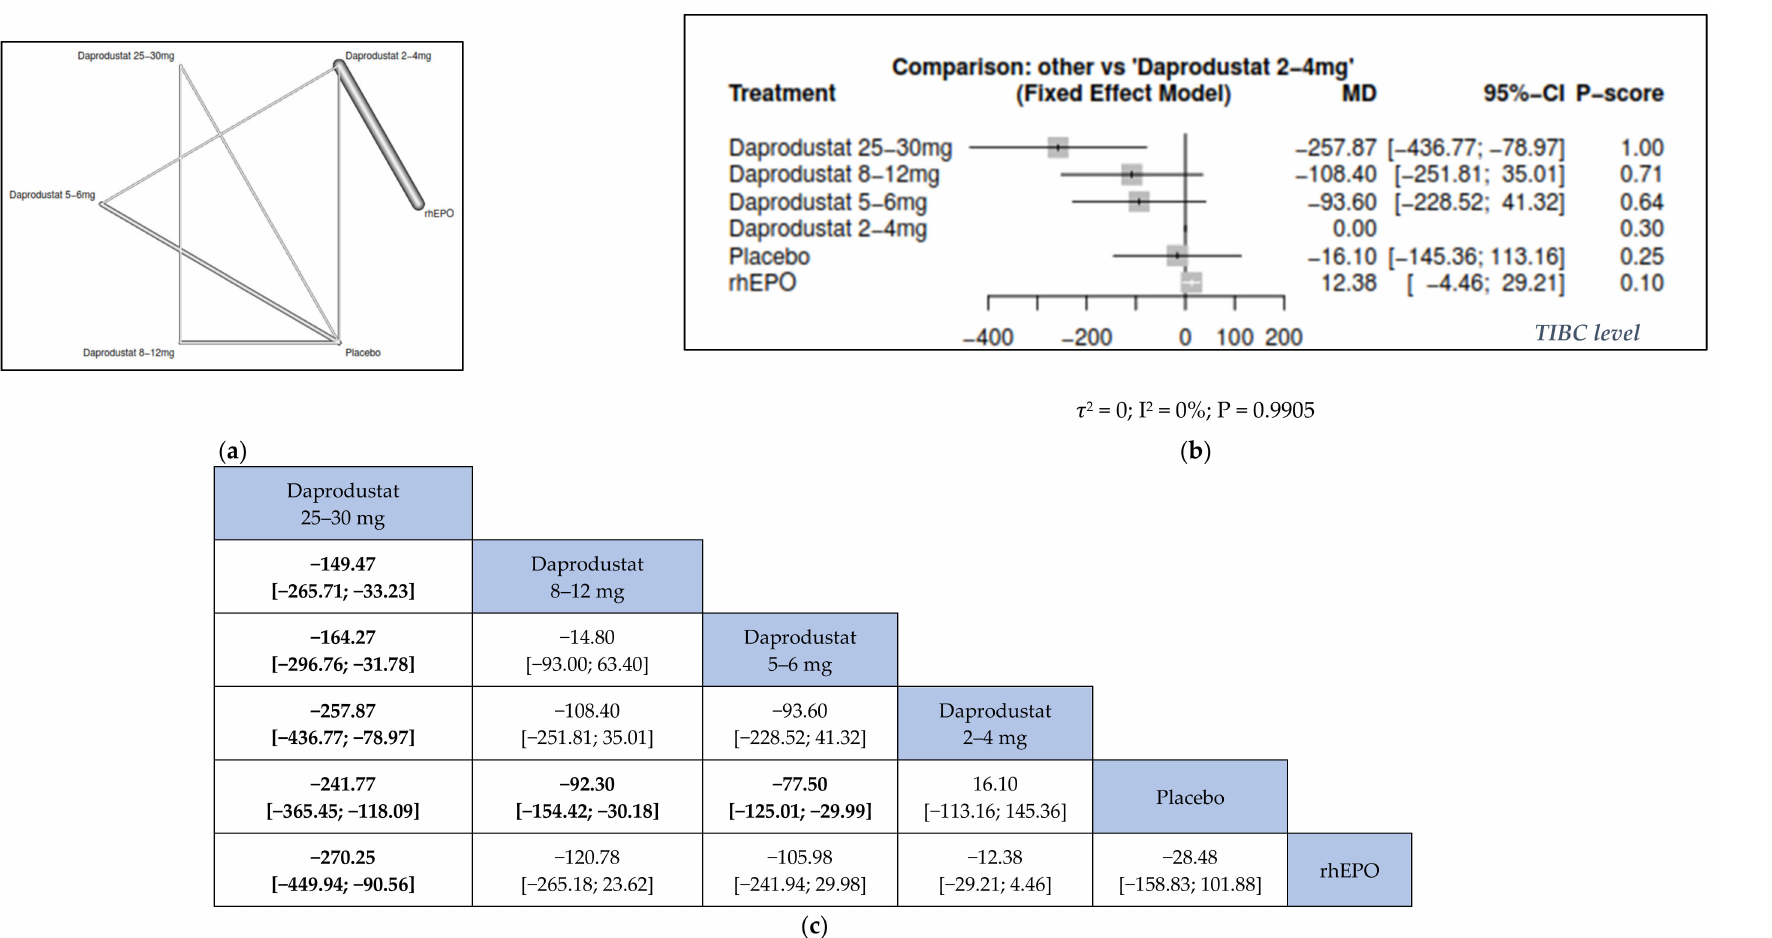
Figure 4. Network meta-analysis results of rate of serum ferritin. ( a ) Network graph showing direct evidence between the assessed interventions. ( b ) A forest plot was generated by comparing all interventions with “placebo”; P-score was used for ranking. ( c ) The league table represents the network meta-analysis estimates for all interventions comparisons; the results are the mean difference (MD) with 95% CI, bold items are statistically